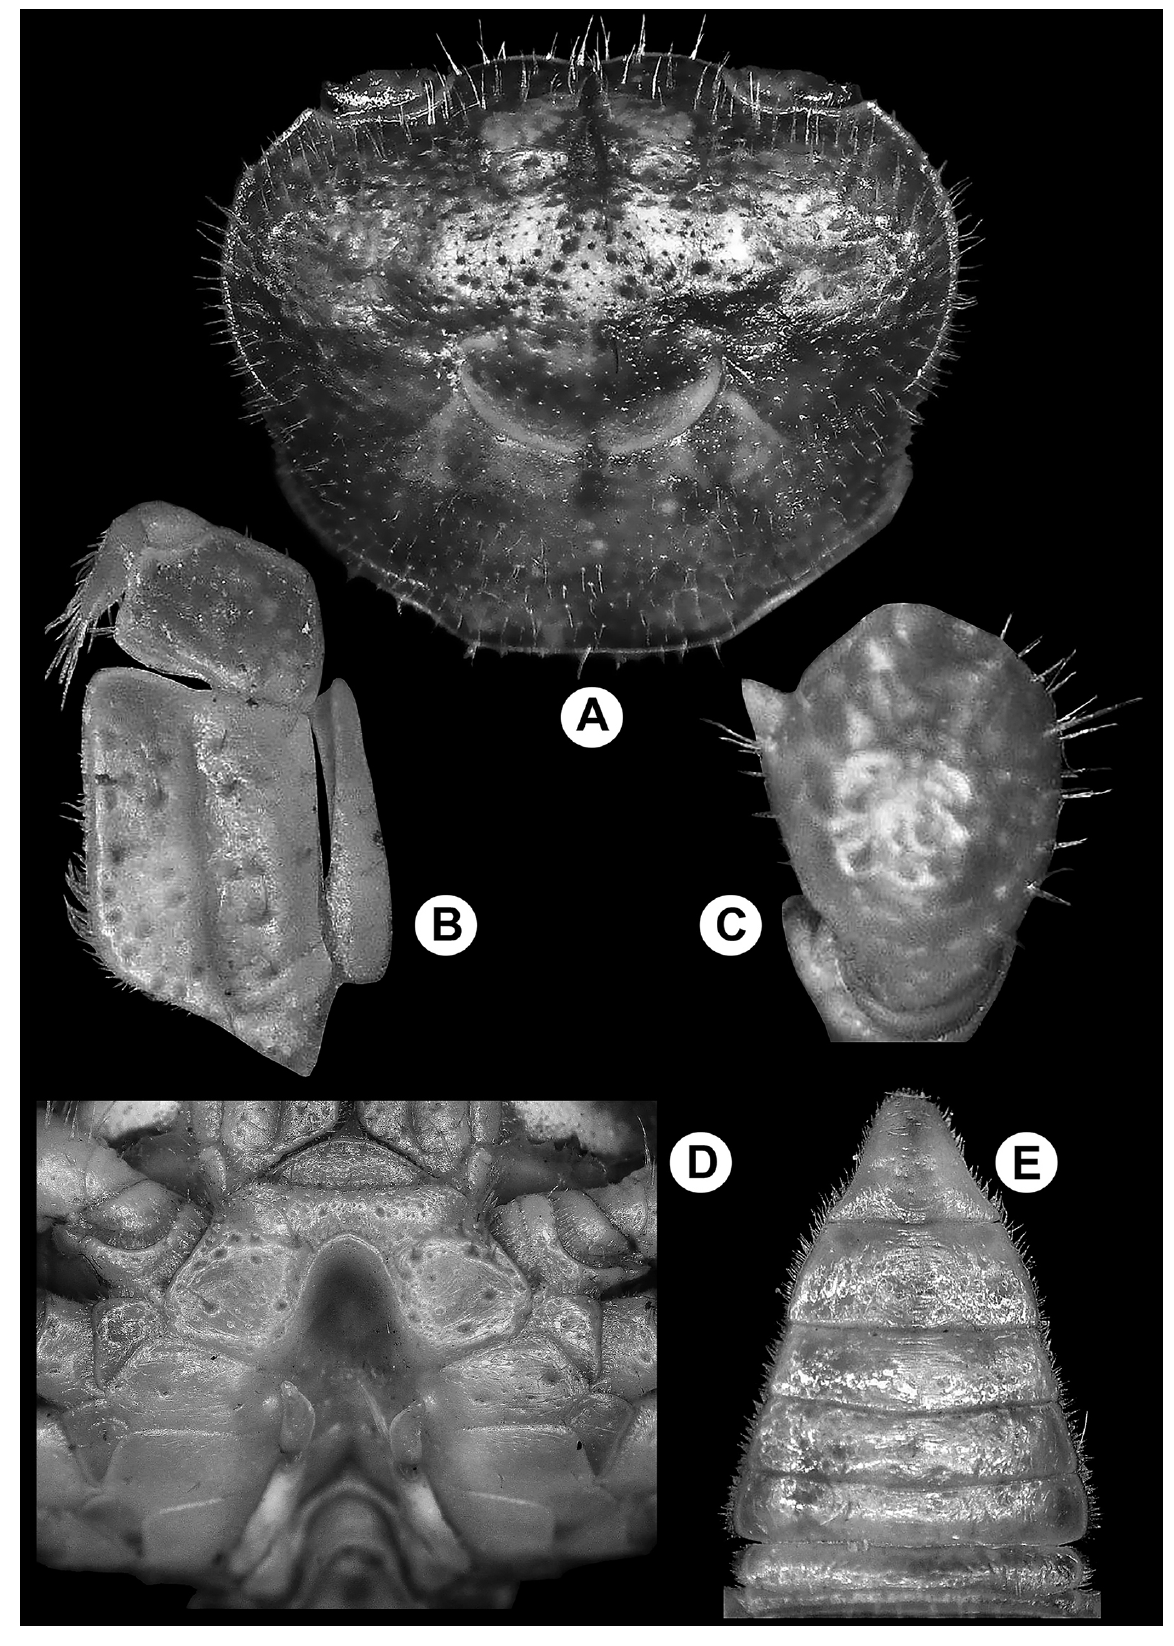
Figure 6. Abormon capillosum sp. nov., paratype male (12.2 × 10.1 mm) (ZSIK C.8611/2). A , dorsal view of carapace; B , left third maxilliped; C , carpus of right cheliped; D , thoracic sternites with G1 in situ ; E , pleon and